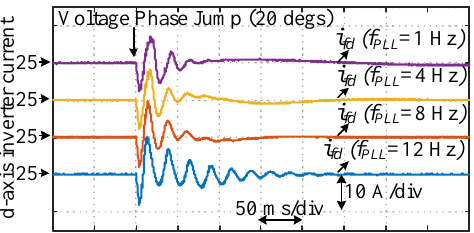
Figure 11. Time-domain simulations showing the system response for 20-degree phase jumps at grid voltage under different PLL bandwidths ( P = P n , SCR = 2).